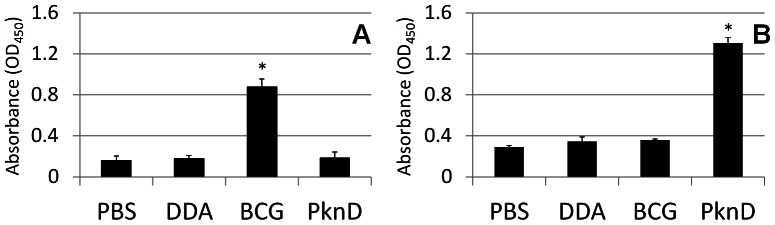

M. tuberculosis PknD-specific IgG in vaccinated guinea pigs.
M. tuberculosis, blood was harvested from each animal to obtain sera. The levels of IgG antibodies reactive to heat-inactivated M. tuberculosis or to recombinant PknD sensor were determined for each group. While sera from BCG-vaccinated animals demonstrated high levels of IgG antibodies reactive to heat-inactivated M. tuberculosis (P<0.01) (panel A), only sera from PknD-vaccinated animals showed high levels of IgG antibodies reactive to PknD (P<0.01) (panel B). Sera from three animals from each group were tested. Each assay was performed in triplicate. Data are presented on a linear scale as mean±standard deviation.